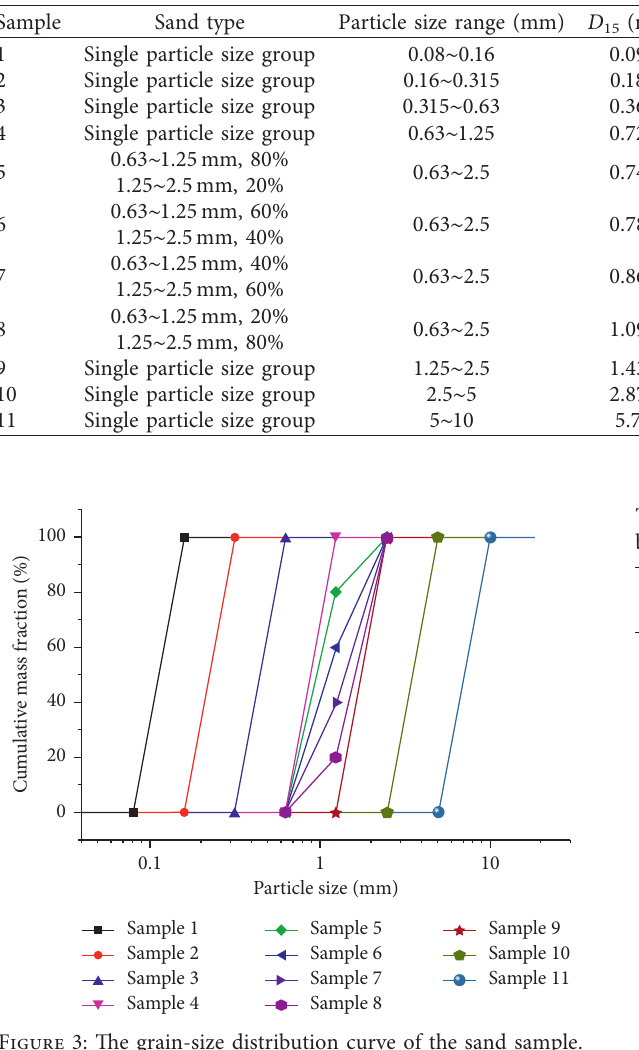
Table 4: The characteristic particle size and other physical parameters.